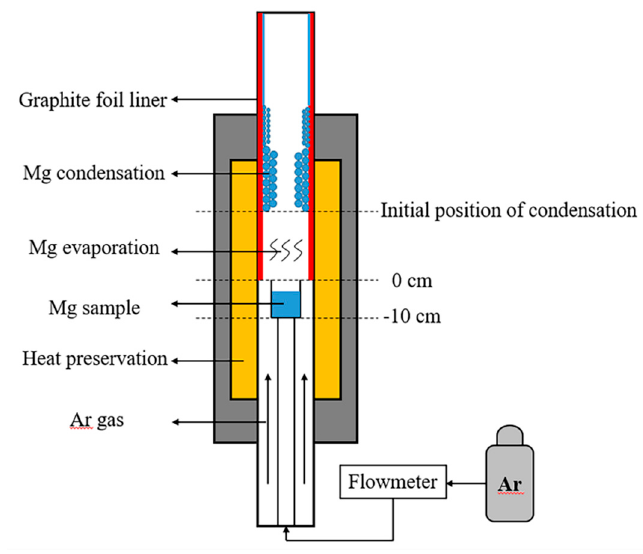
Figure 1. Schematic diagram of Mg vapor condensation.